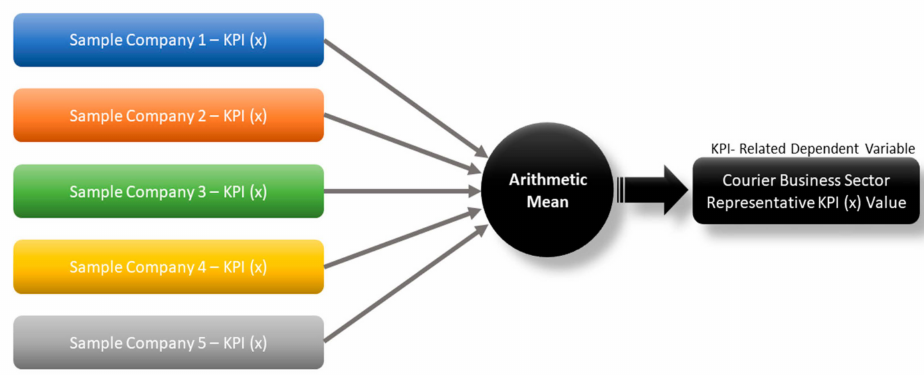
Figure 3. Initial-data process methodology.